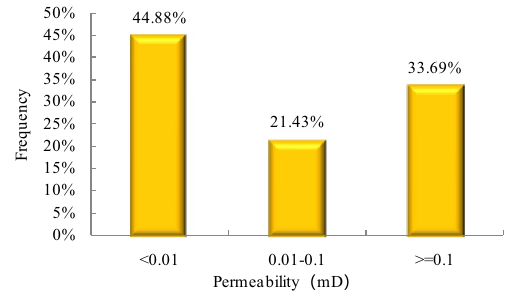
Fig. 2 Permeability distribution of Deng-4 zone reservoir in MX-E block in the platform